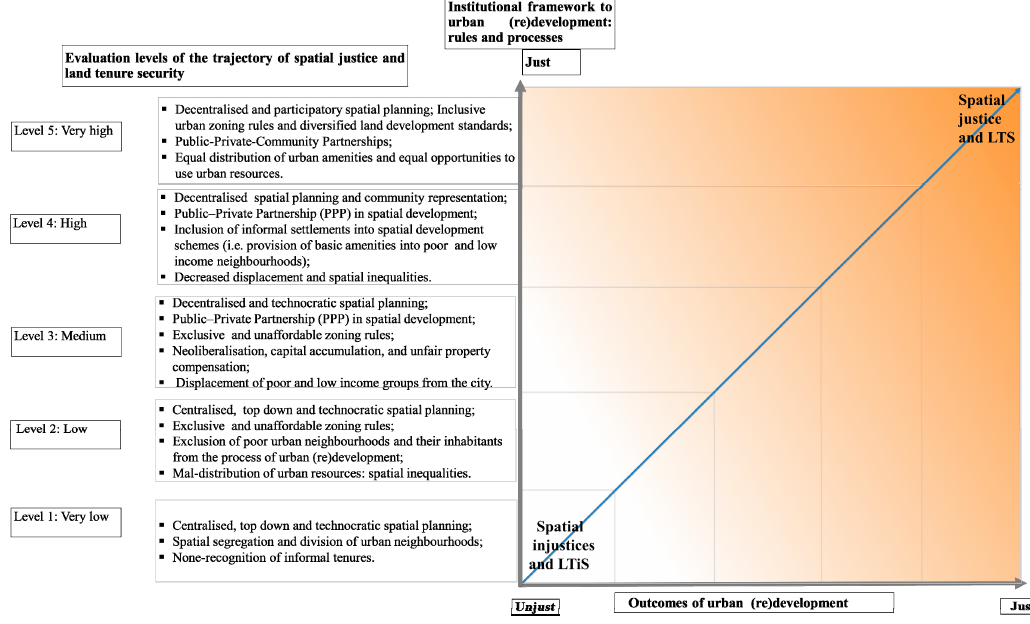
Figure 3. The continuum of spatial justice and land tenure security (LTS). Developed based on [5,7,15,16,48,61,69,95,127,128,132]. LTiS, land tenure insecurity.